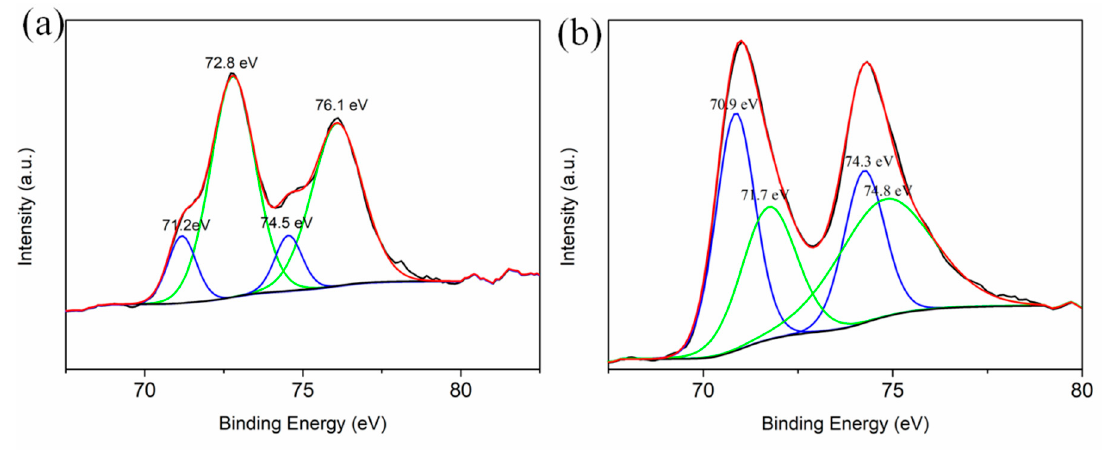
Figure 3. The XPS spectra of Pt 4f for ( a ) S1 and ( b ) S2. Table 1. The Pt valence state distribution over the samples.